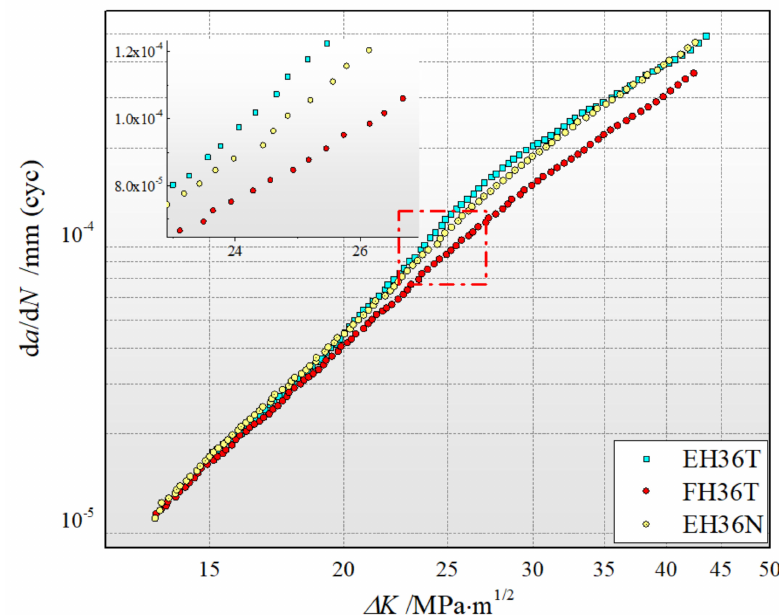
Figure 11. Fatigue crack growth behavior of offshore structural steel plates.